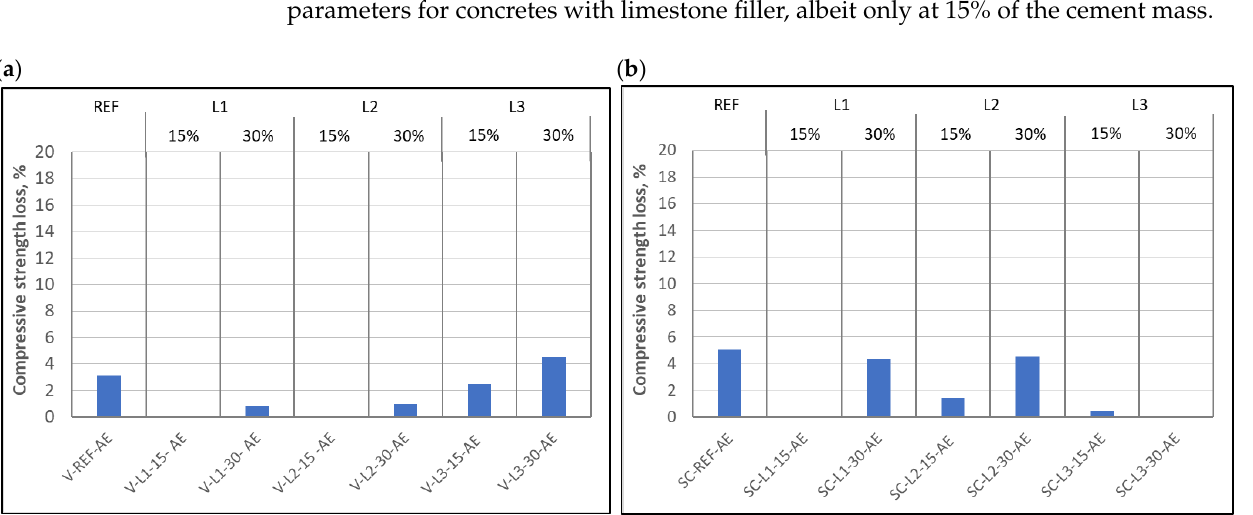
Figure 11. ANOVA analysis of the effect of limestone type on the compressive strength for reference samples (REF) and samples after 100 cycles of freeze – thaw (FT) for ( a ) vibrated concretes without AEA, ( b ) SCC without AEA, ( c ) vibrated concretes with AEA, ( d ) SCC with AEA.